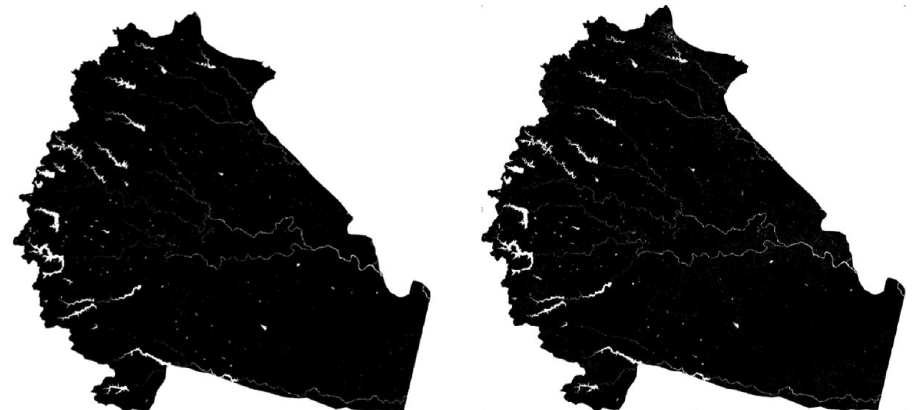
Figure 7. Sample image of trial and error threshold images on the date 21st January 2016 and 6th February 2016. Landsat 8 image courtesy of the U.S. Geological Survey.